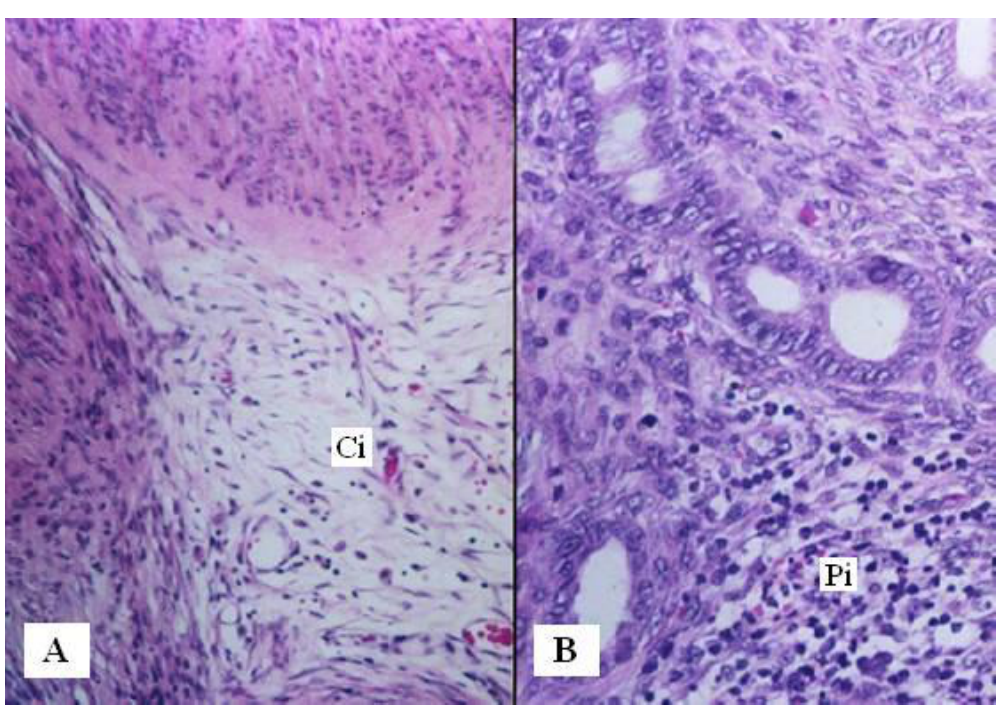
(Pi) glandular chorion. 3